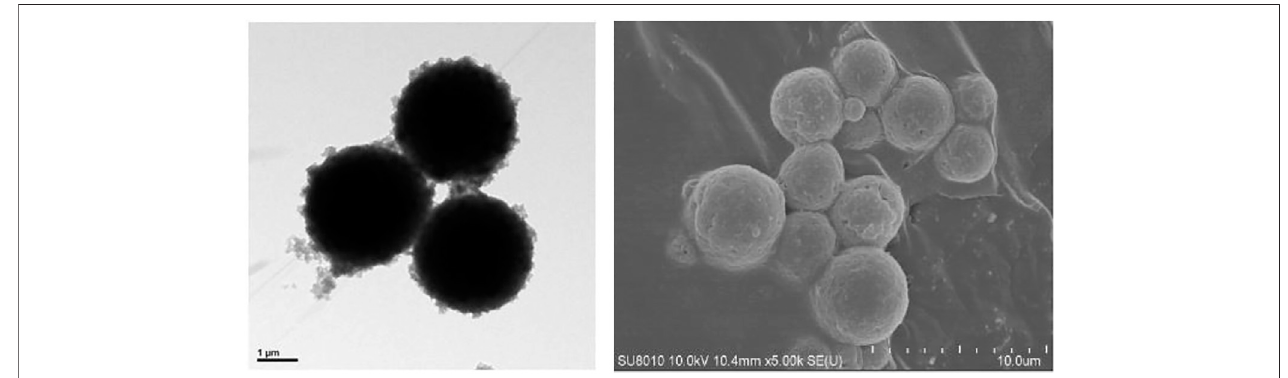
FIGURE 1 | The property of self-assembly in static and dynamic conditions.